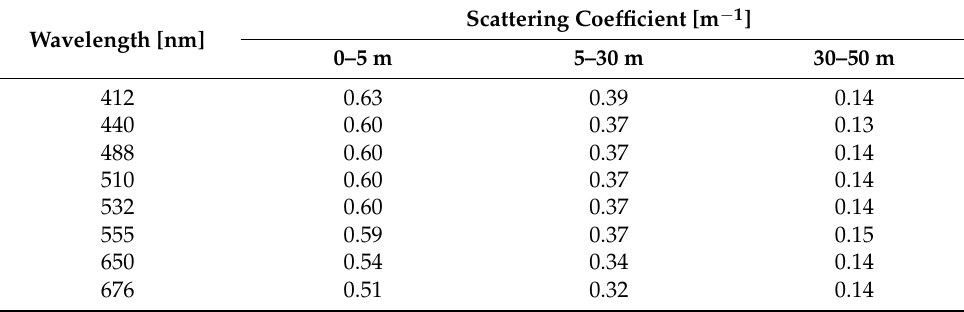
Table 2. The scattering coefficient used in the sea environment optical model [25].